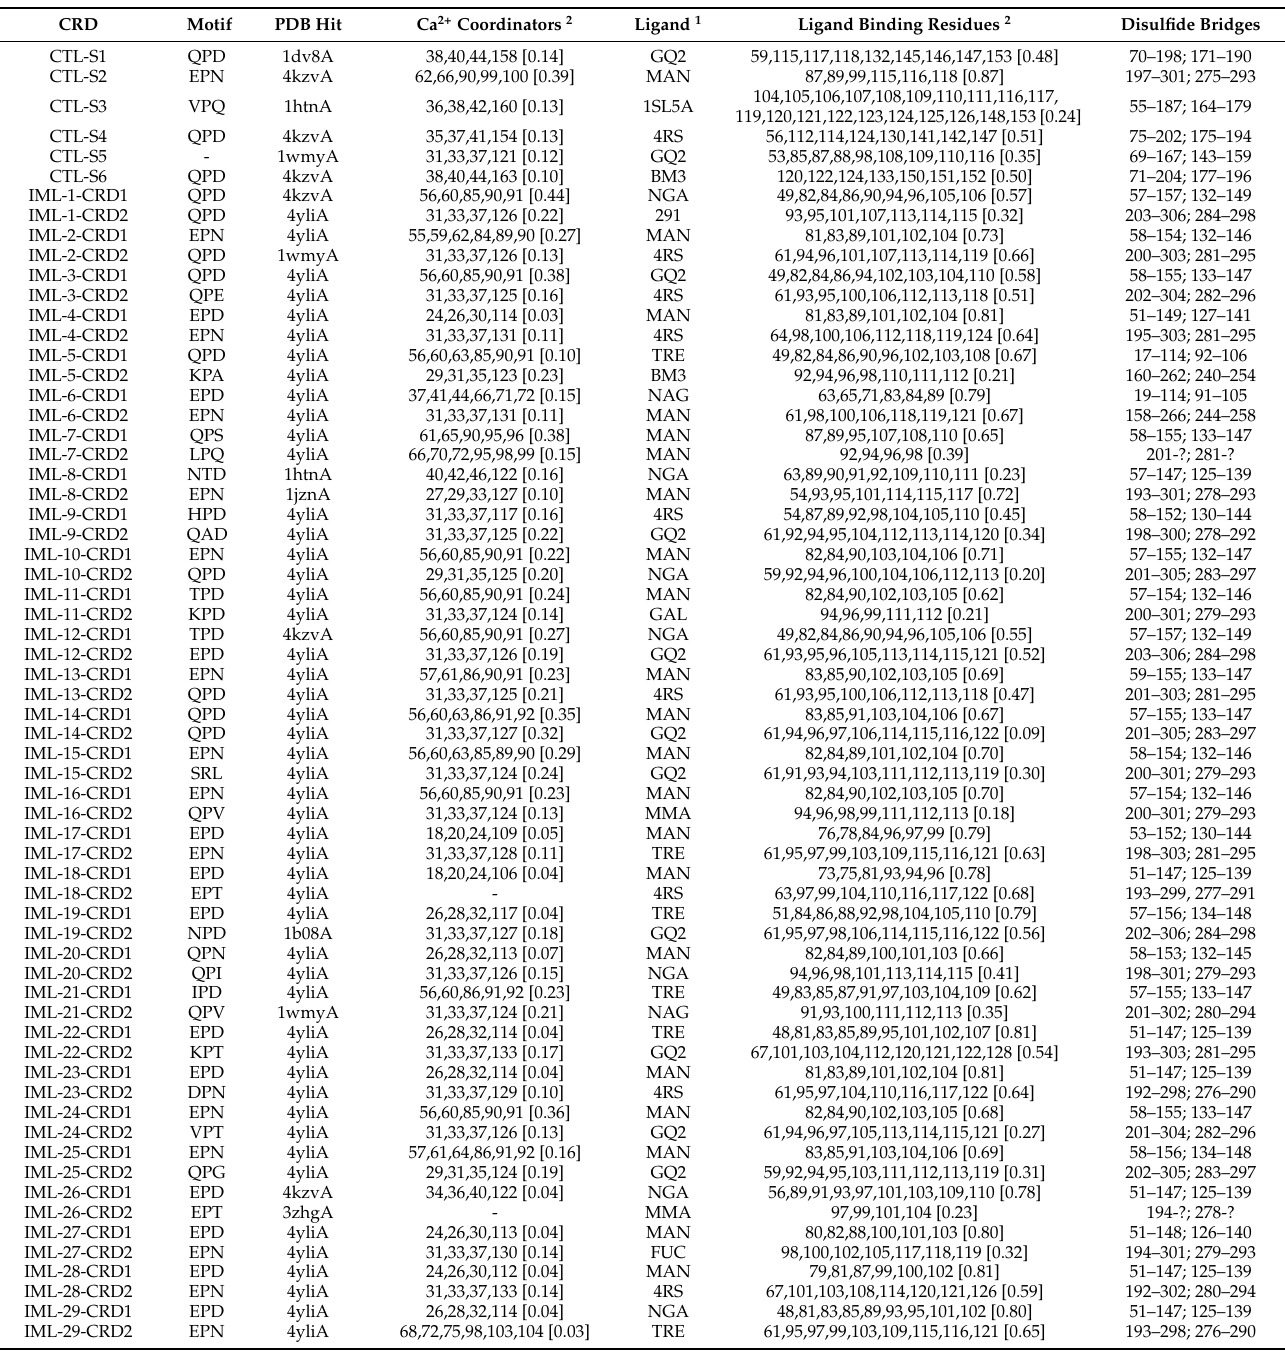
Table 3. Sequence features of CRDs.